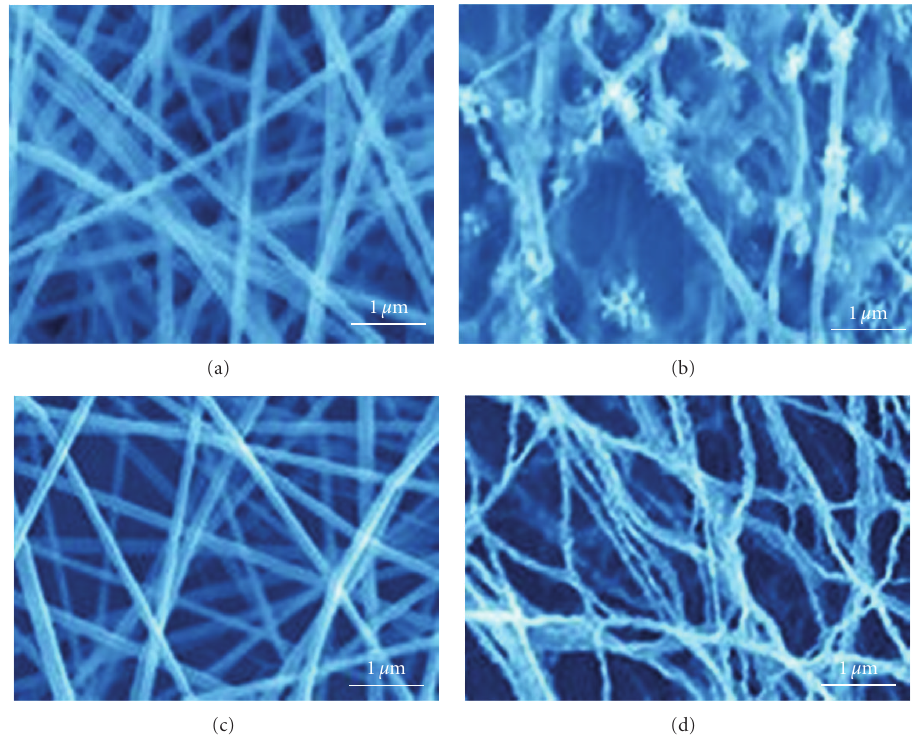
Figure 2: SEM images of (a) PVP-Mn(NO 3 ) 2 -AgNO 3 nanofibers, (b) Mn 2 O 3 -Ag nanofibers, (c) PVP-Mn(NO 3 ) 2 nanofibers, and (d) Mn 2 O 3 nanofibers, respectively.